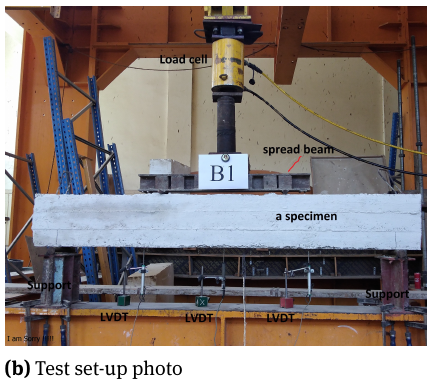
Figure 3: Experimental test